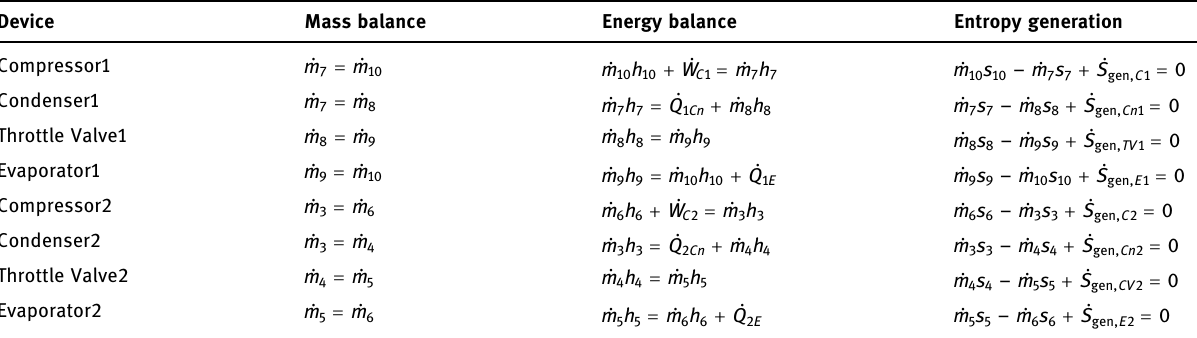
Table 2: Formulas for the mass and energy balance and entropy generation of the devices of the two - stage vapor compression cascade cryogenic cycle [ 2,4 – 6 ]